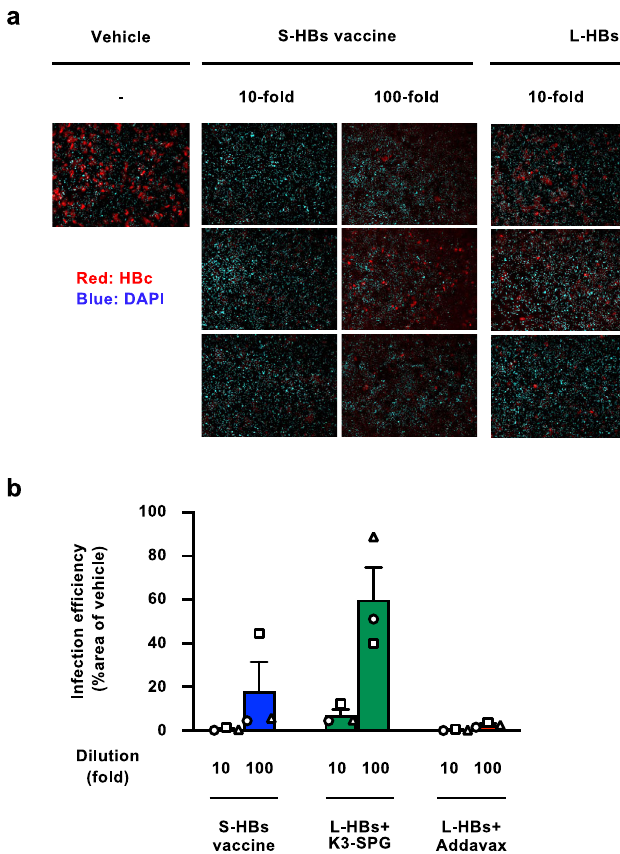
Fig. 2 | Neutralization of HBVcc infection by serum samples of immunized rhesus macaques. a HBVcc (GTC, 1000 GEq/cell) was treated with 10- or 100-fold diluted serum samples of rhesus macaques immunized with the indicated HB vaccines and infected with HepG2-NTCPsec+ cells. HBVcc treated with PBS was used asa vehiclecontrol.The infectedcellswere detected by staining with ananti- HBc antibody 12 days after infection, and the nuclei were visualized by DAPI. The